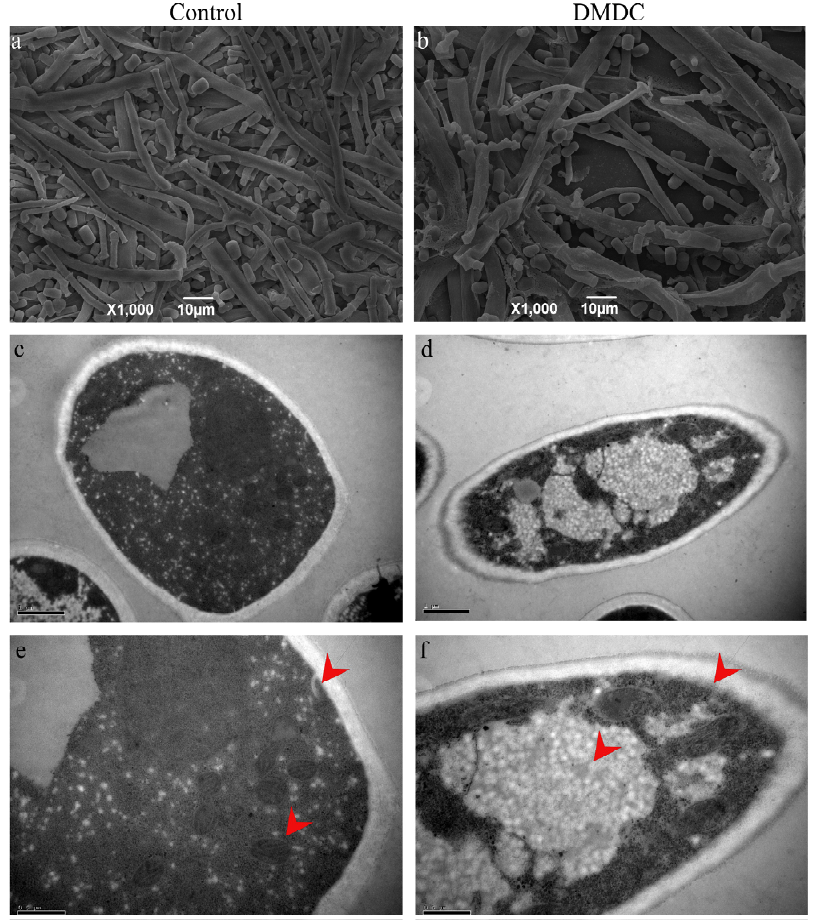
Figure 7. SEM and TEM observation of G. citri-aurantii treated with 250 mg/L DMDC. SEM observation in the control group ( a ) and treated with 250 mg/L DMDC ( b ); TEM observation in the control group ( c , e ) and treated with 250 mg/L DMDC ( d , f ).